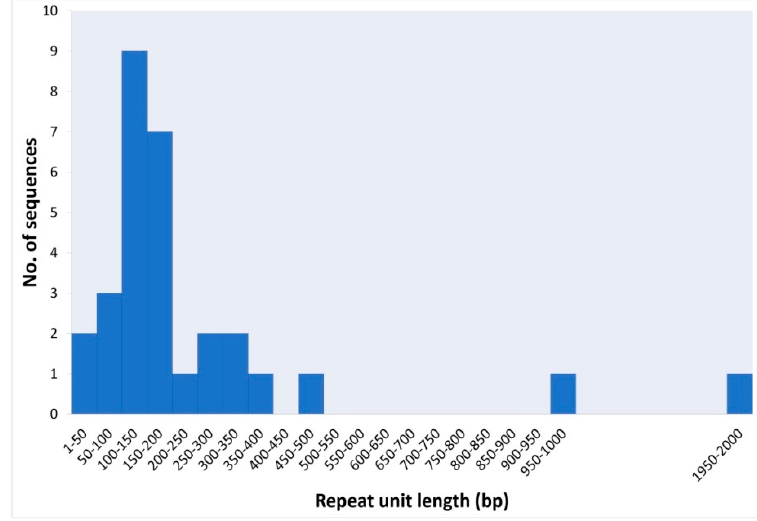
Figure 3. Size distribution of all the satDNAs characterized in Hippodamia variegata .